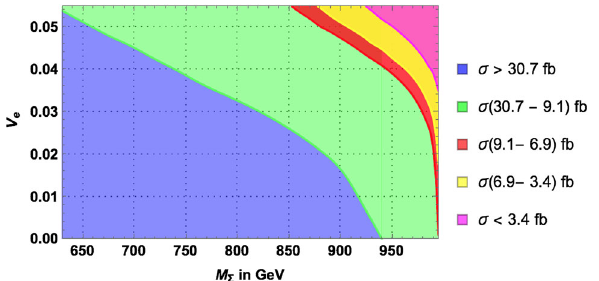
Fig. 6 Regions of M (cid:2) – V e plane with different ranges of cross section values for pair production at 2 TeV centre-of-mass energy as indicated. The ranges of cross sections are the 3 σ limiting values given in Table 8